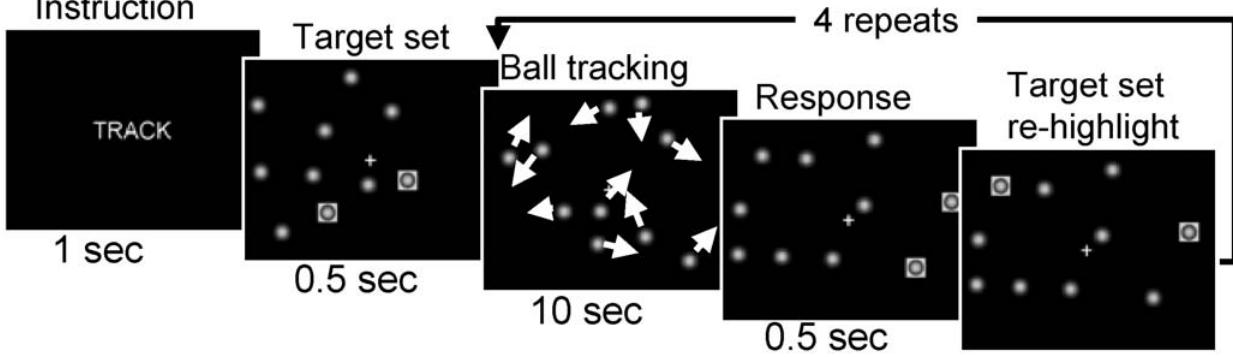
Figure 2. Visual attention (VA) paradigm. During ‘‘TRACK’’ epochs of the 2-ball tracking task, subjects tracked the target ball set that was briefly highlighted after the instruction. Then all 10 balls moved with a random motion for 10 seconds and the subjects tracked the target balls until the balls stop moving. Then subjects responded by pressing a button if the highlighted balls were those they were tracking. Finally the target set was re- highlighted to refocus the subjects’ attention on the balls. This track and respond sequence was repeated 5 times during the 1-minute long ‘‘TRACK’’ epochs.